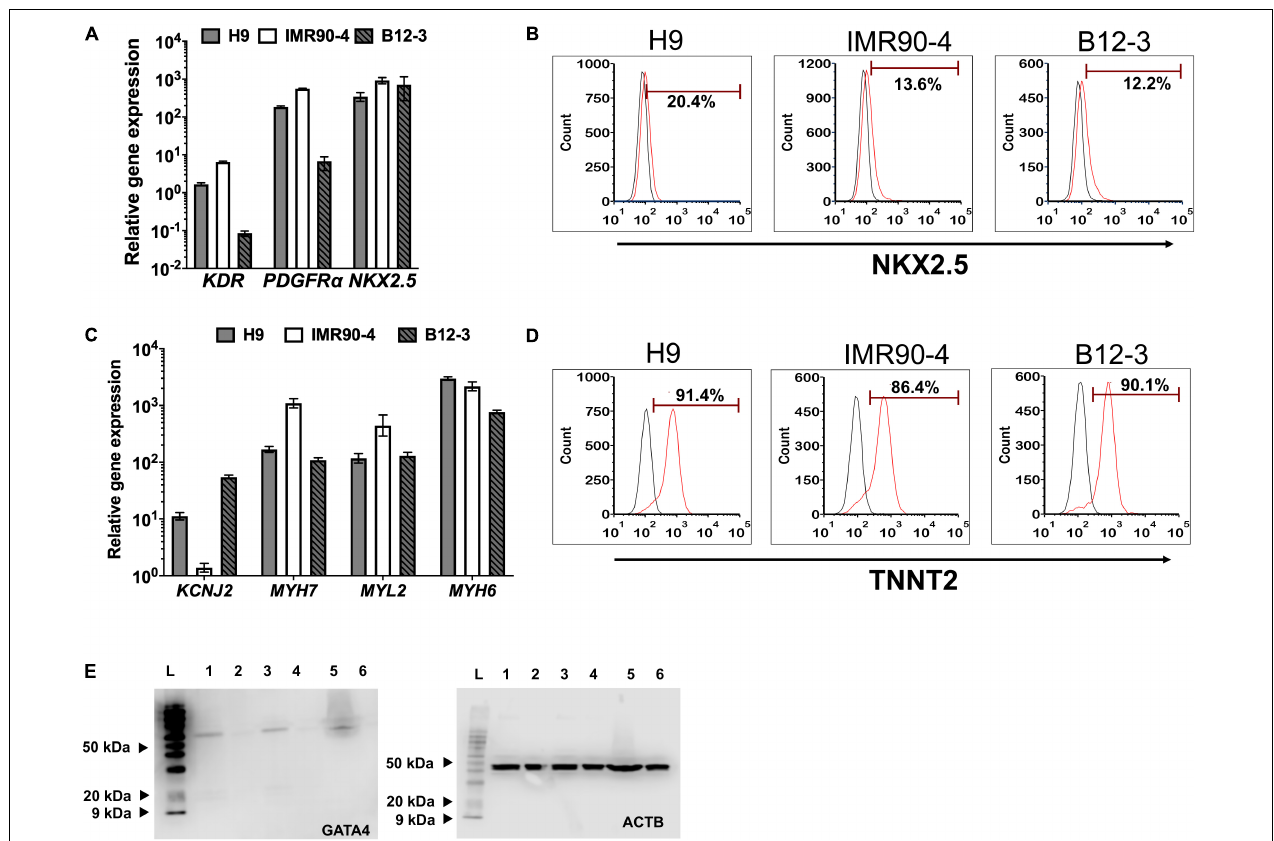
FIGURE 2 | Differentiation of hPSC-derived MoPS cells toward CMs: After 12–24 h of treatment with BMP4 (30 ng/ml) and Wnt3A (100 ng/ml), canonical Wnt signaling is inhibited with KY02111 (10 µ M) from days 2–8. (A) Expression of early cardiac mesoderm (day 3) in hPSC-derived cells. (B) Representative plots of NKX2.5 expression in cells from H9 (21.8 ± 4.08%), IMR90-4 (11.61 ± 2.73%), and B12-3 (7.87 ± 3.8%) cells during transition through the cardiac mesoderm stage (see Figure 1A ). Results are shown as mean ± SD ( n ≥ 3). (C) Relative CM gene expression on day 16 of differentiation. (D) Flow cytometry analysis of differentiated H9 (91 ± 0.71%), IMR90-4 (81.31 ± 1.32%) and B12-3 (84.57 ± 5.12) hPSCs for TNNT2 expression. Black curve, isotype control. (E) Western blot of GATA4 ( ∼ 60 kDa) at the end of differentiation for hPSCs (H9:1-2, IMR90-4:3-4, B12-3 hPSCs: 5–6; directed differentiation: 1,3,5; no differentiation factor controls: 2,4,6; L: ladder). ACTB ( ∼ 40 kDa) is also